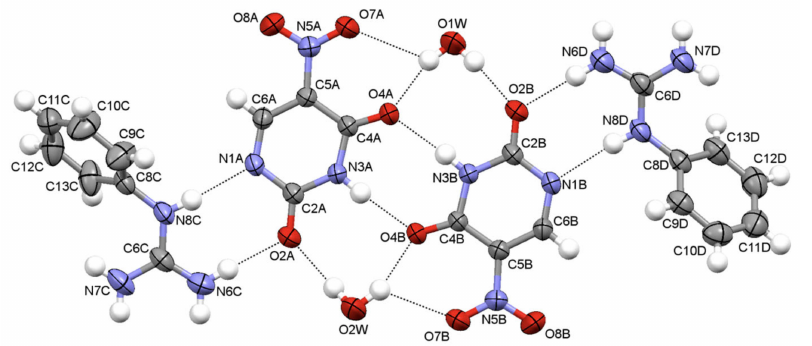
Figure 22. A plot with the symmetry-independent molecular units of phenylguanidinium 5- nitrouracilate monohydrate. Displacement ellipsoids are drawn at the 50% probability level. Hydro- gen bonds are shown as dashed